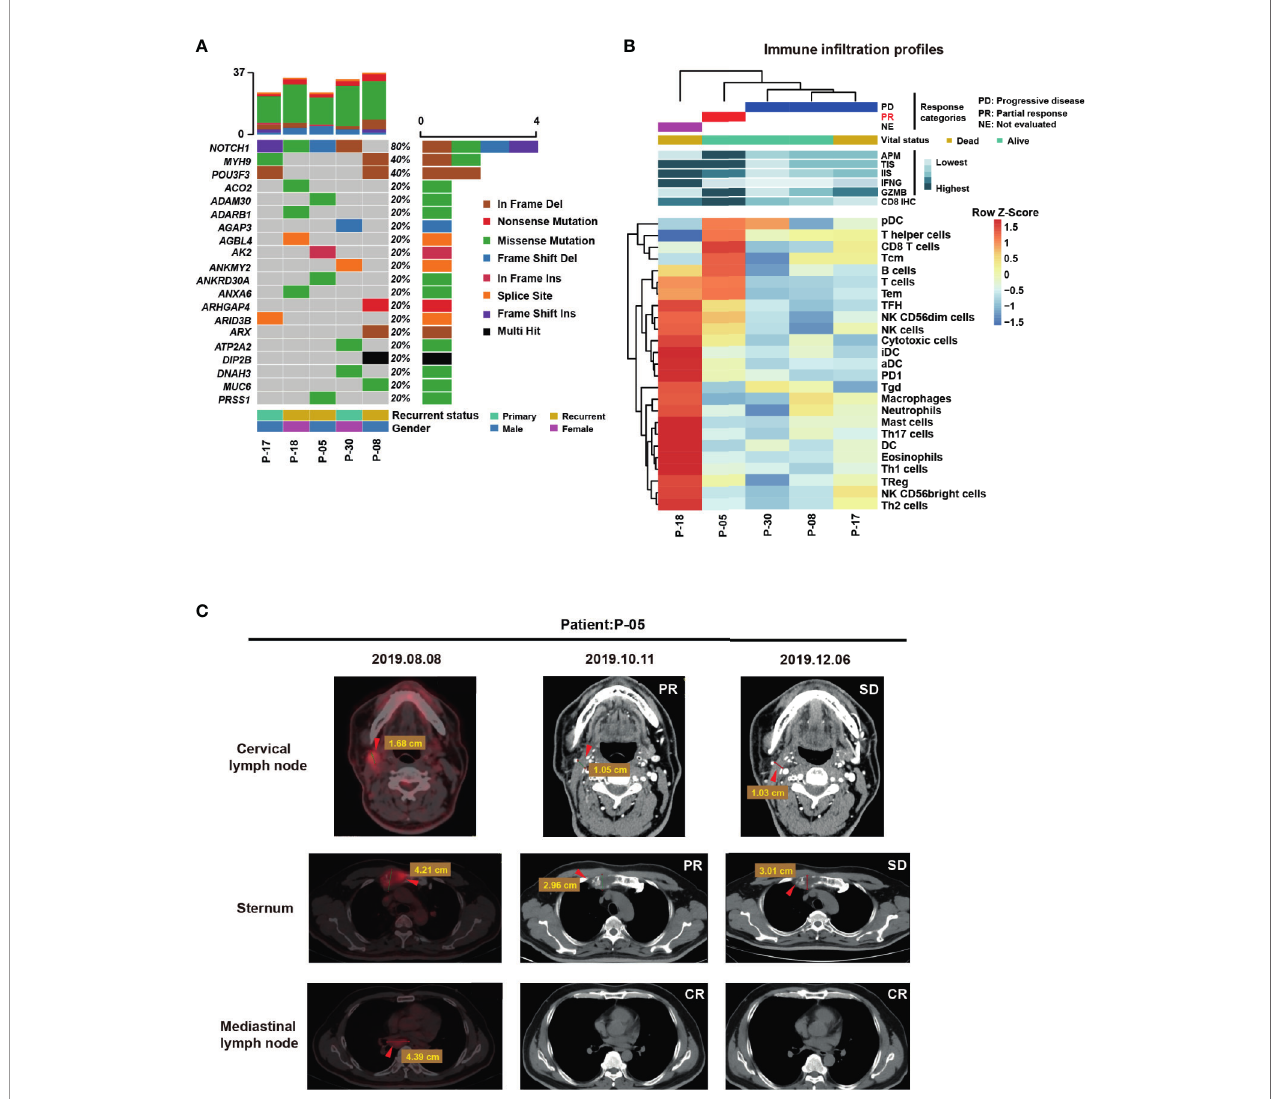
FIGURE 5 | Mutational and Immune In fi ltration Pro fi les in anti-PD1 inhibitor- treated ACC patients. (A) Data from combined WES sequencing of samples was analyzed to generate an oncoplot showing distribution of mutations. (B) RNA-Seq pro fi les of fi ve ACC patients were generated and the patients were then treated with the anti-PD1 inhibitor pembrolizumab or camrelizumab. T cell in fi ltration as well as APM, TIS, and GZMB levels are generally high in a responder (partial response to camrelizumab). (C) Detection of recurrent metastatic ACC on positron-emission tomography-computed tomography (PET-CT) with 18 F- fl uorodeoxyglucose ( 18 F-FDG) or CT. Images represent axial CT scans with volume reduction by RECIST criteria. The 53-year-old man (case No.P-05) in these images underwent immunotherapy and radiation therapy from August to December 2019. PET-CT was performed in August 2019. Axial views on PET (left panel) show disease recurrence with widespread metastases (red arrows). Contrast-enhanced CT was performed after the 4 cycles of immunotherapy in October 2019 and showed remarkable reduction in the volume of three metastases (middle panel, red arrows). Contrast-enhanced CT was performed after the 8 cycles of immunotherapy in December 2019 and showed stable disease (SD) (right panel, red